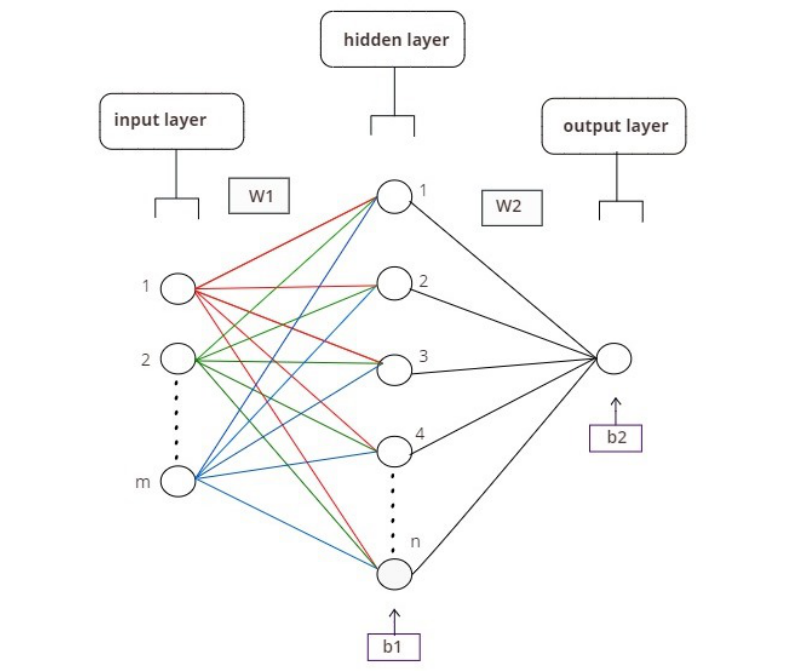
Figure 4. A generalized artificial neural network architecture with a single hidden